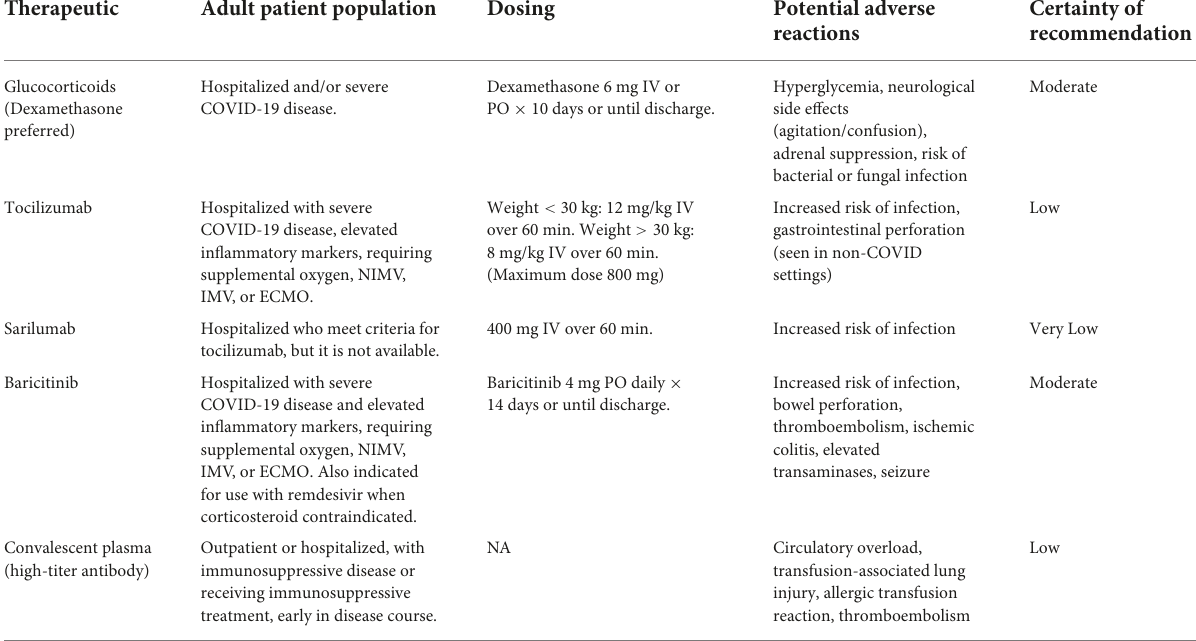
TABLE 1 Immunomodulatory therapies recommended by the Infectious Diseases Society of America (IDSA) and/or FDA for COVID-19